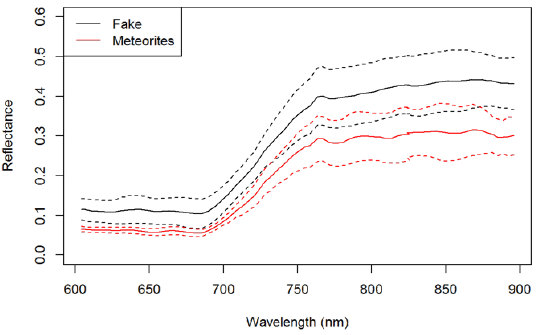
Figure 9. Mean and standard deviations of hyperspectral image-based reflectance spectra of the meteorites and ordinary rocks used in the experimental field